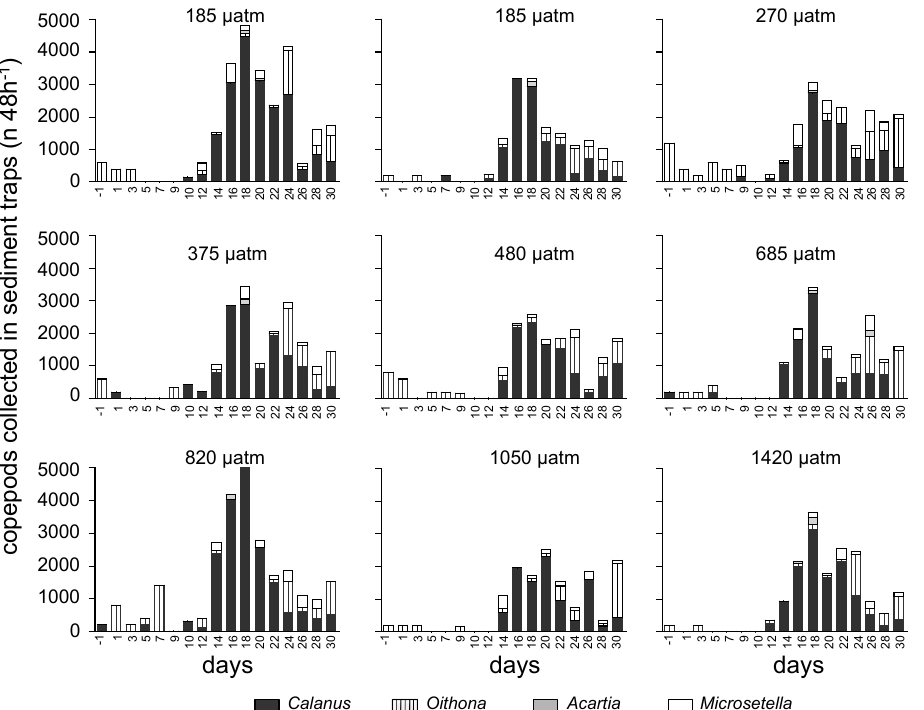
Fig. 9. Copepod abundance and taxonomic composition (genera) in the sediment traps of the mesocosms; data presented here include copepodites and adults of the respective genus; numbers on top of the panels present the initial CO 2 concentration in each mesocosm after the CO 2 manipulation was